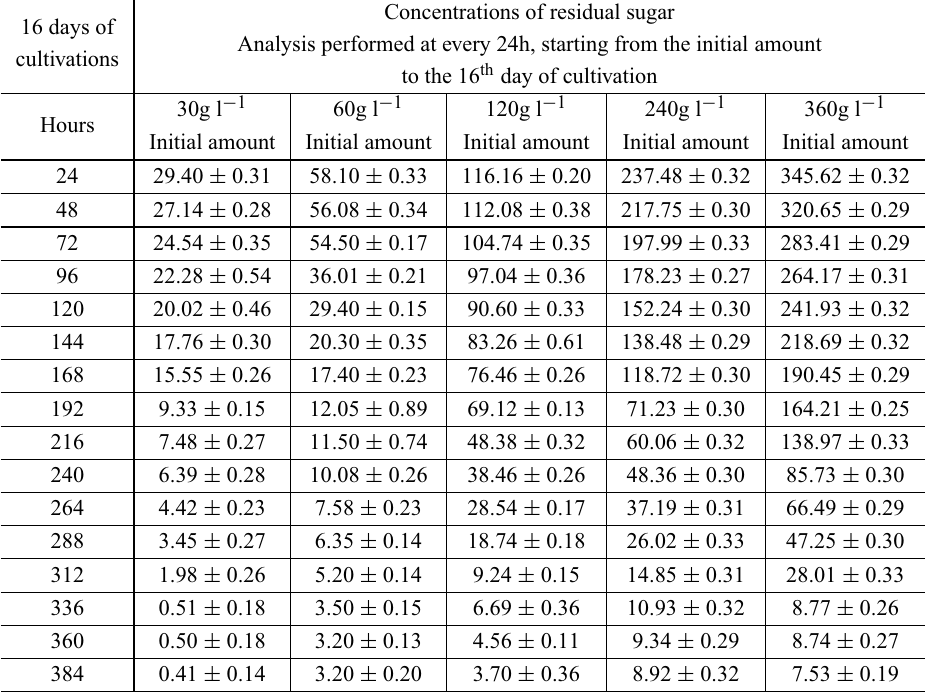
Residual sugar concentration in a Czapek Dox liquid medium. Concentrations of residual sugar 16 days of Analysis performed at every 24h, starting from the initial amount cultivations to the 16 th day of